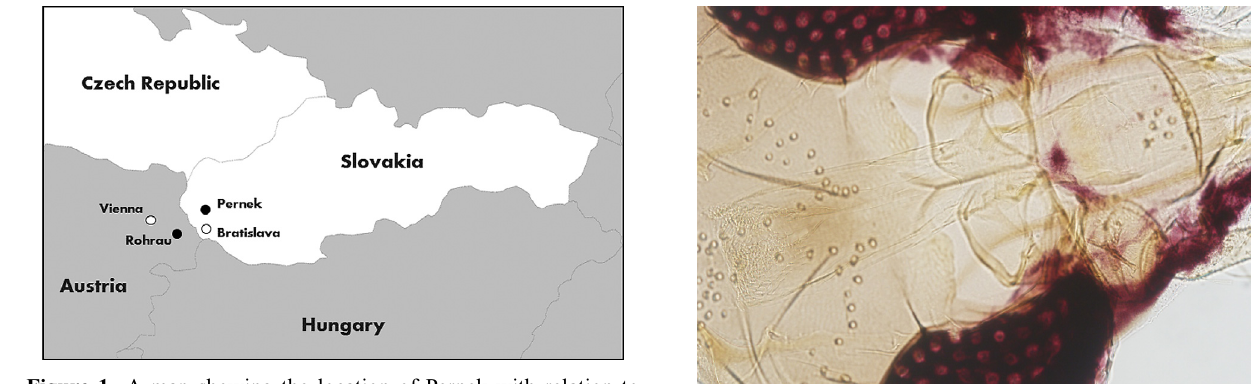
Figure 1. A map showing the location of Pernek with relation to the nearest previous record of Ph. mascittii in Rohrau,